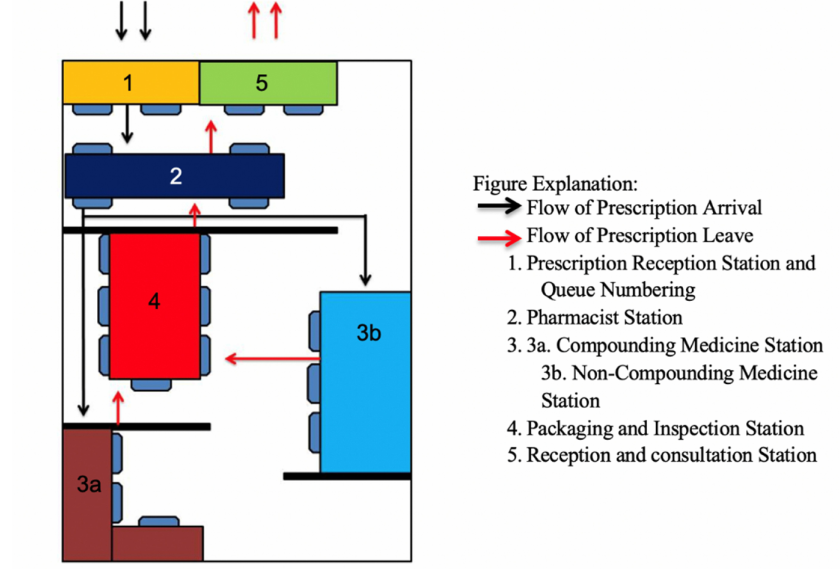
Fig. 2 Floor Plan of the Outpatient Pharmacy